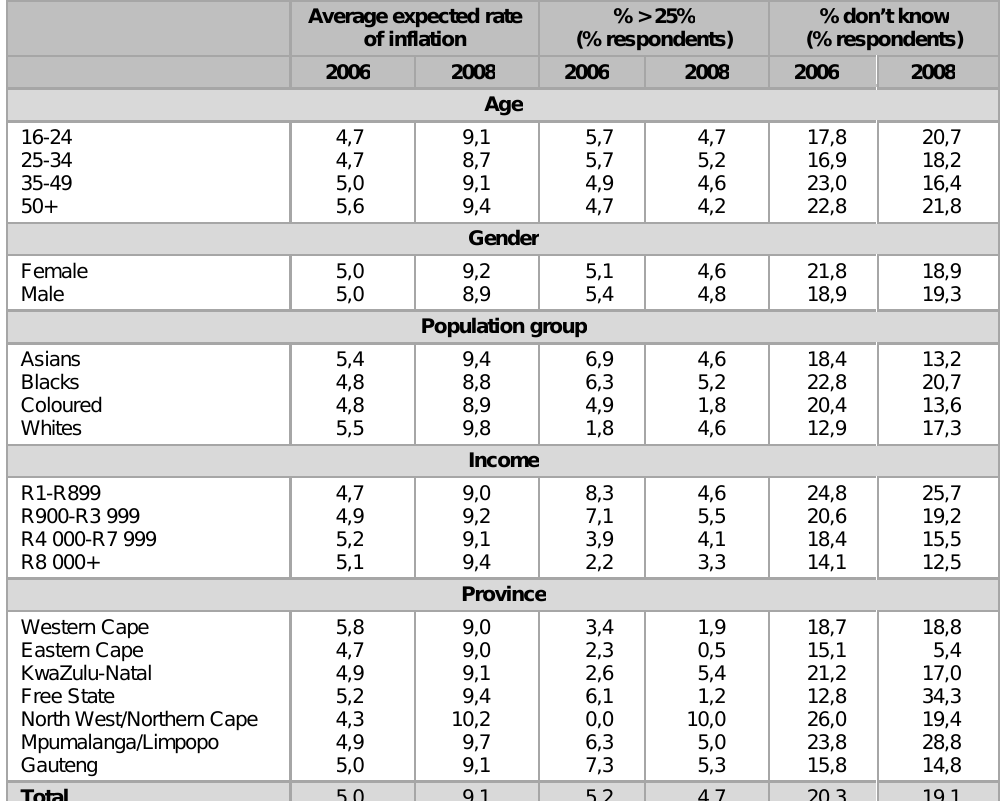
Average of responses about inflation expectations according to age, gender, population group and the total, 4 th quarter 2006 and